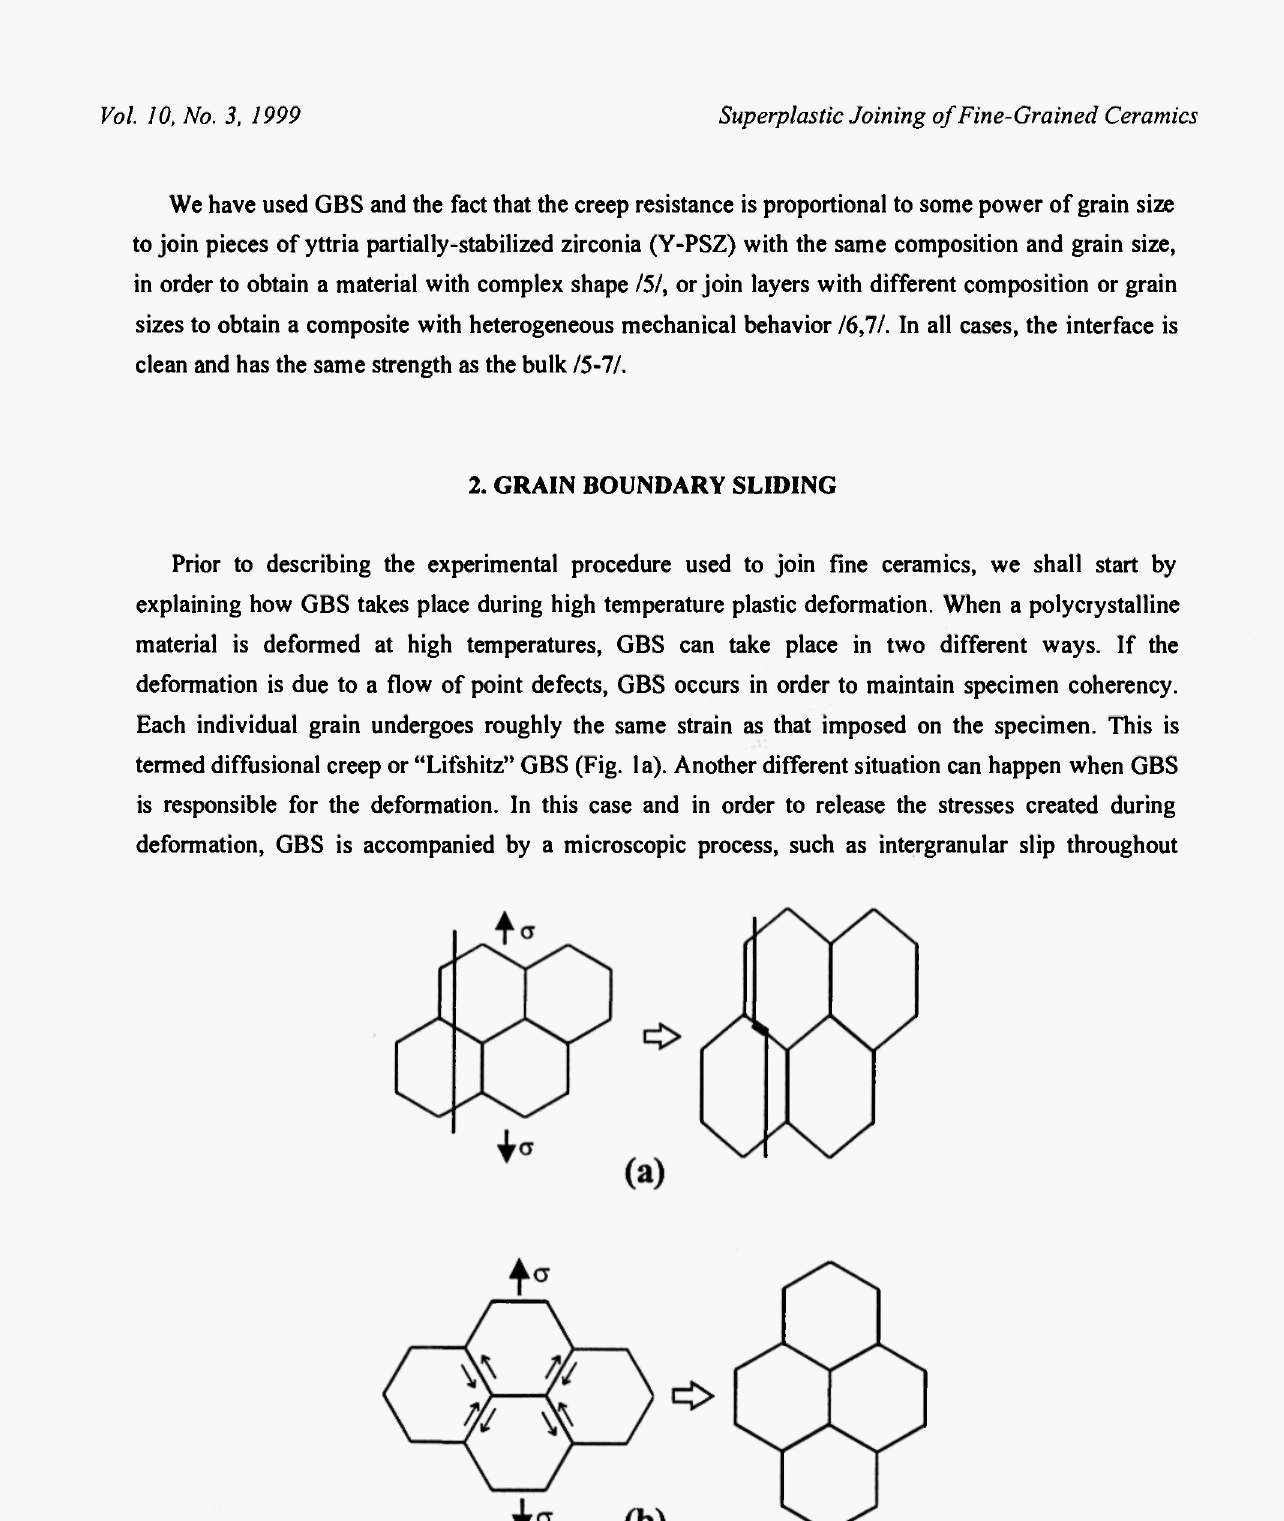
Fig. 1: (a) Schematic of the Lifshitz grain boundary sliding. The line shows the GBS after deformation, (b) Schematic of the Rachinger grain boundary sliding, showing the morphological characteristics of the deformation (i.e., the grain shape remains